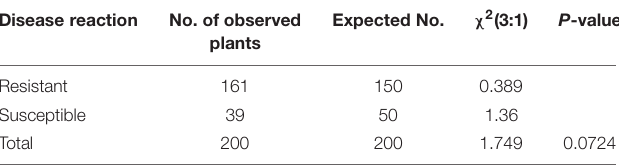
TABLE 2 | Phenotypic segregation ratio of observed and expected number of resistant and susceptible plants in the BC 2 F 2 population inoculated with highly virulent pathotype P7.2 of Magnaporthe